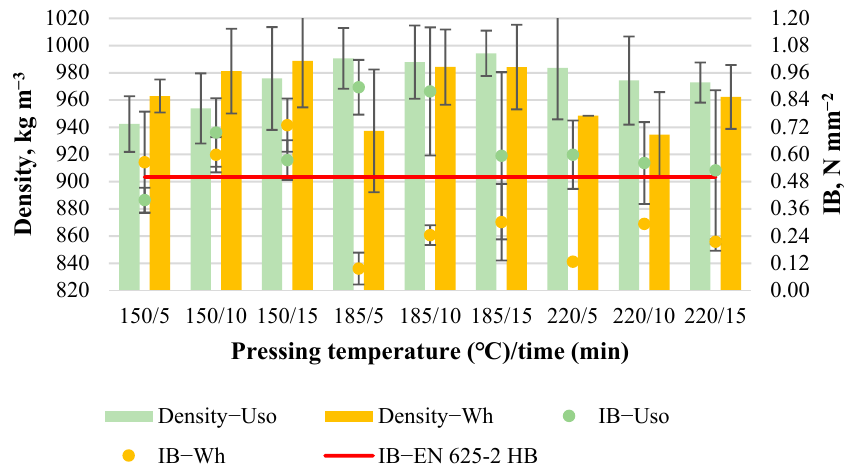
Figure 7. Density and IB of binder-less boards with a density of 1000 kg m − 3 depending on the crop and pressing variables.